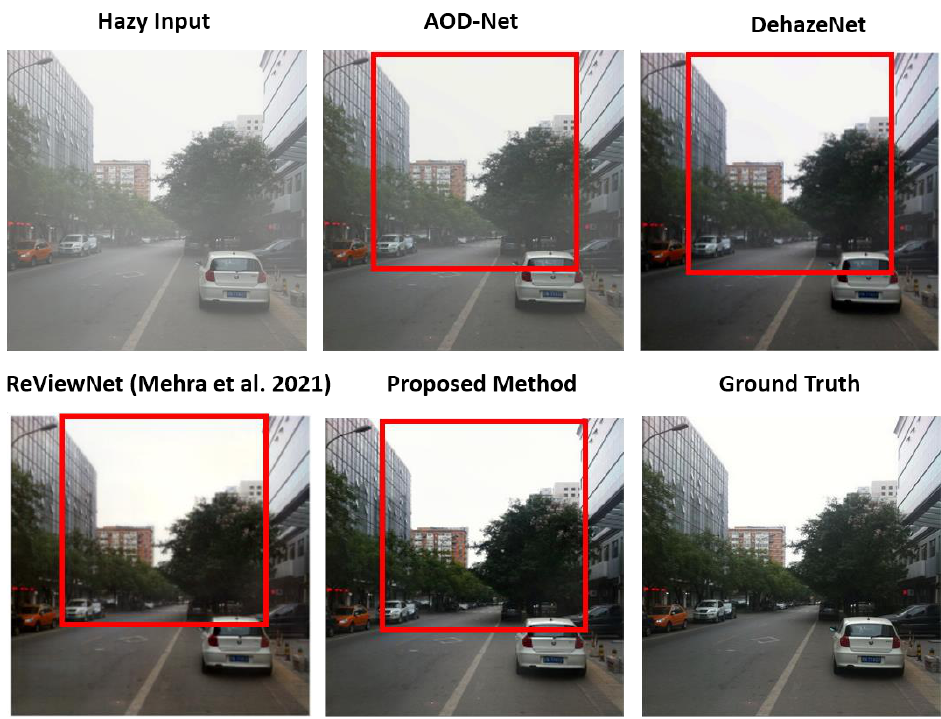
Figure 10. Comparison of dehazing results of urban road [28].